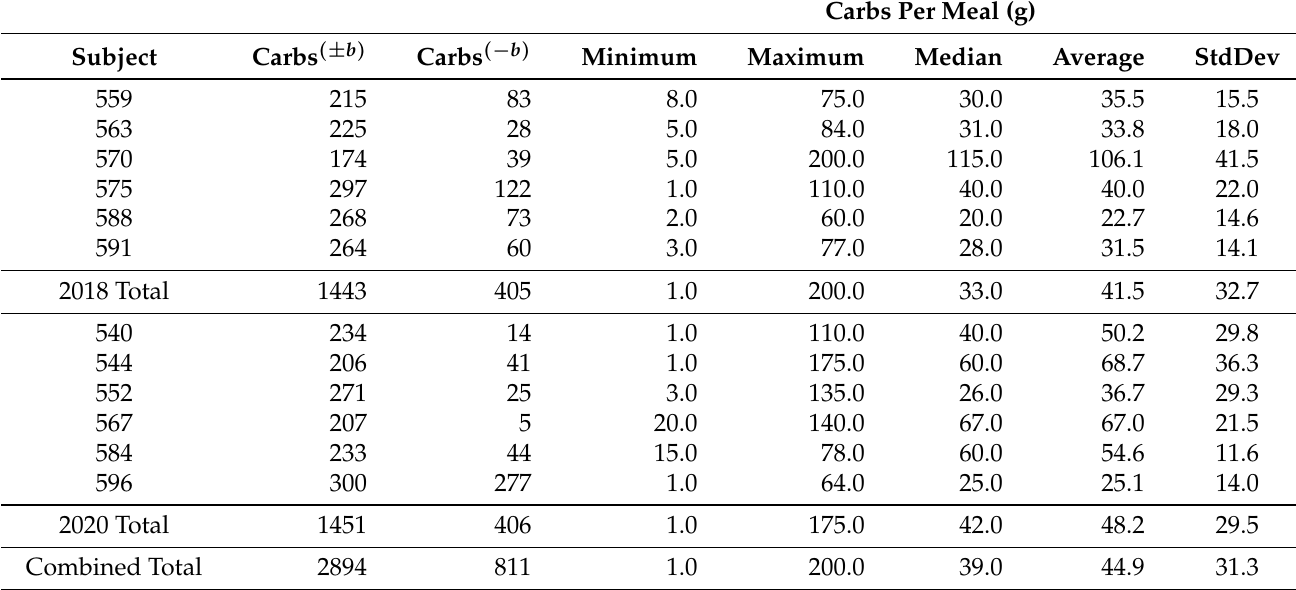
Table 1. Per subject and total meal and carbohydrate per meal statistics: Minimum, Maximum, Median, Average, and Stan- dard Deviation (StdDev). Carbs ( ± b ) refers to all carbohydrate intake events; Carbs ( − b ) refers to carbohydrate intakes without a bolus. Statistics are shown for the 2018 subset, the 2020 subset, and for the entire OhioT1DM dataset. Carbs Per Meal